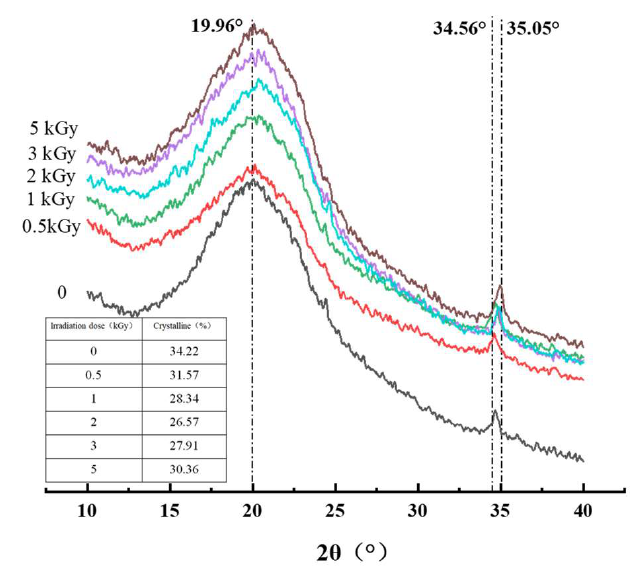
Figure 3. Effects of γ-irradiation on X-ray diffraction of pea fiber.